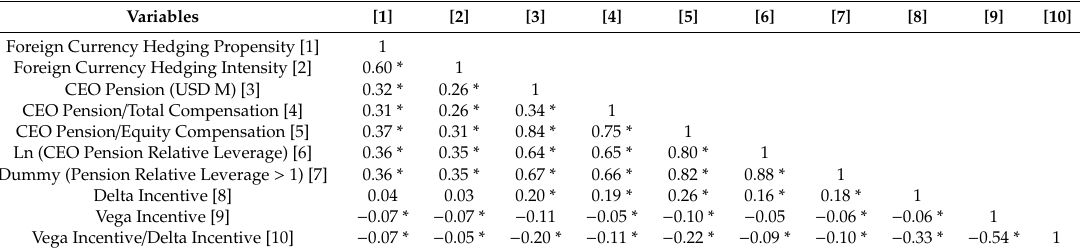
Table 2. Correlations matrix between hedging and pension